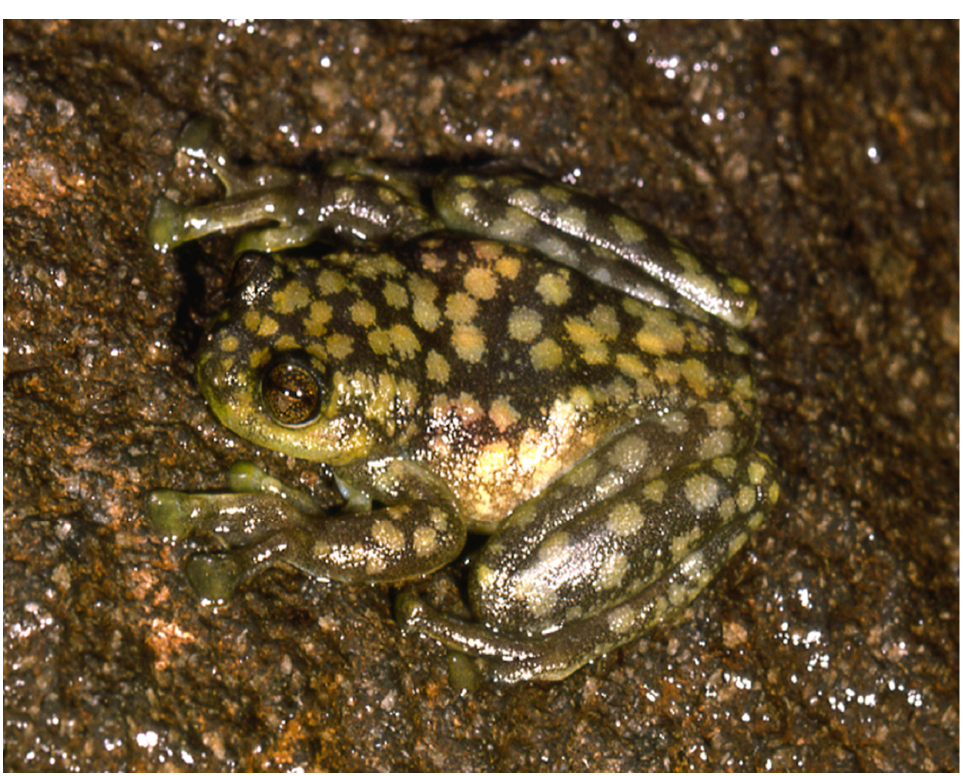
Figure 47. “Centrolene” medemi in life. Adult female (KU 164493) from 2 km SSW of junction between Río Reventador and Baeza-Lumbaqui road, Ecuador. Photo by William E. Duellman. Diagnosis: (1) Teeth on dentigerous process of the vomer present or absent, each process bearing zero to four teeth; (2) snout round in dorsal profile, truncated to slightly protruding in lateral profile (Figure 48); (3) tympanum small, tympanum diameter 17.1%–18.5% of eye diameter, dorsal third of tympanum covered by supratympanic fold, tympanic membrane pigmented and not clearly differentiated from surrounding skin; (4) dorsal surfaces of males and females smooth to shagreen; males with small spicules on dorsum and flanks; (5) pair of slightly enlarged subcloacal warts; (6) anterior half of the ventral parietal peritoneum white (condition P2); silvery white pericardium; no iridophores in peritonea covering the intestines, stomach, testes, kidneys, gall bladder, and urinary bladder (condition V1); (7) liver tetralobed, two large ventral lobes covering two smaller lobes; hepatic peritoneum lacking iridophores (condition H0); (8) in males, small humeral spines present; (9)